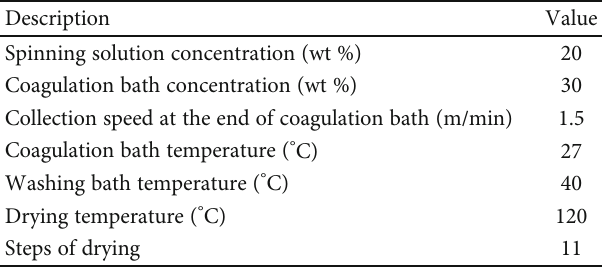
Figure 3: Schematic of wet spinning line. 1, storage column with a spinning solution; 2, spinnerette; 3, coagulation bath; 4, driven rollers; 5, washing bath; 6, stretching bath; 7, drying; 8, collapsing; 9, collect-rolling. Table 2: Operating conditions employed in the spinning system.